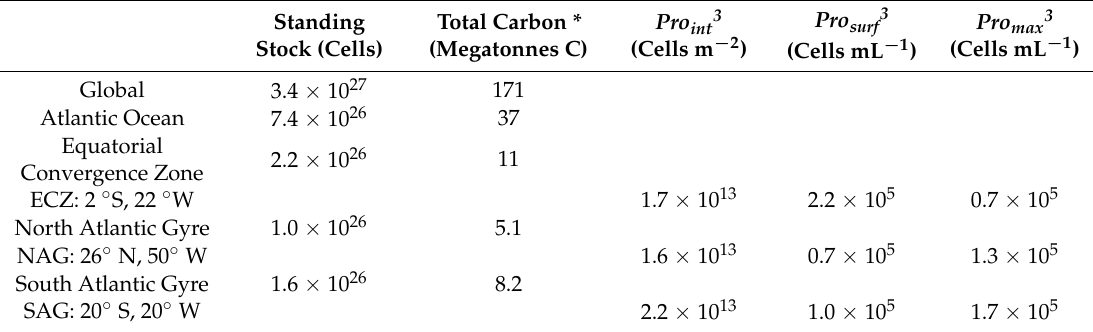
Table 4. Predicted Prochlorococcus standing stock in the oceans, integrated horizontally and vertically at each area. Values were computed using Equations (1)–(10), with monthly climatology products used as input variables [22], then averaged over the year. Pro int3 , Pro surf3 and Pro max3 were calculated at specific geographic locations within each Atlantic gyre (coordinates in the table). Standing Total Carbon * Pro int3 Stock (Cells) (Megatonnes C) (Cells m − 2